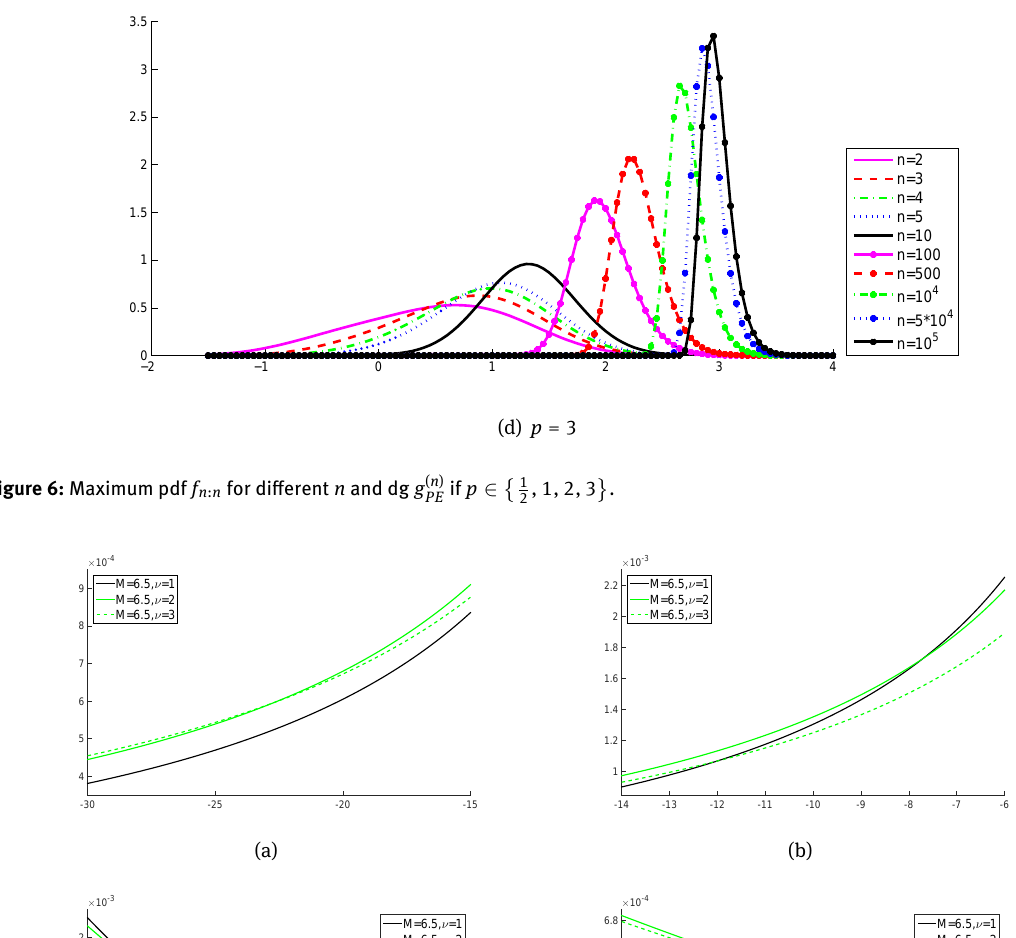
Figure 7: Some detailed views on the graphs of the right hand side of Figure 5(a).